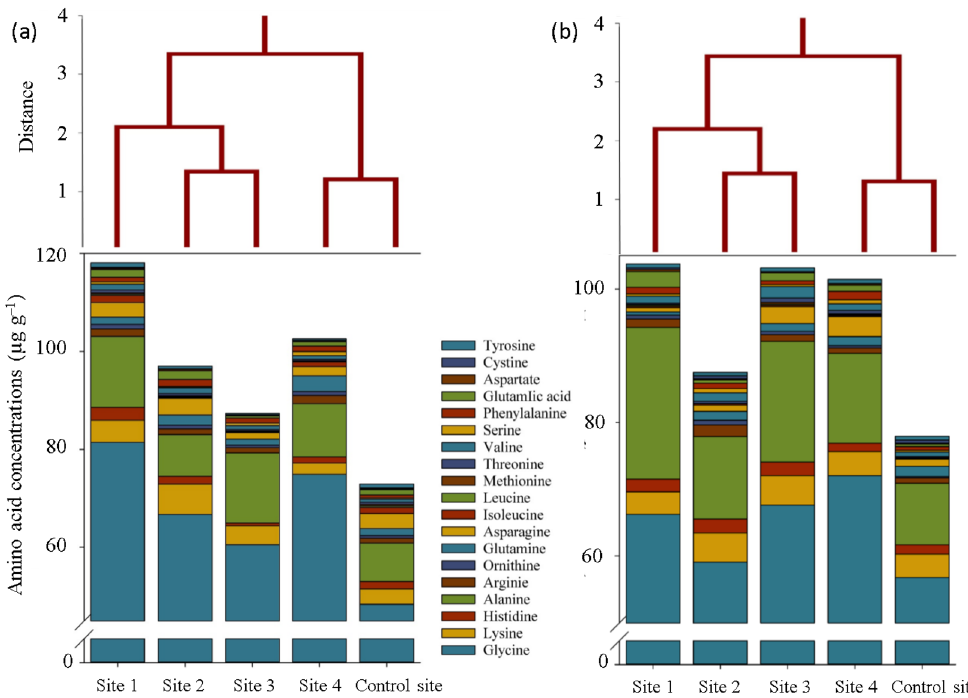
Figure 1. Amino acid composition and related cluster analyses (Ward’s method) in the shoot ( a ) and root ( b ) of S. portulacastrum plants at different levels of heavy metals pollution.